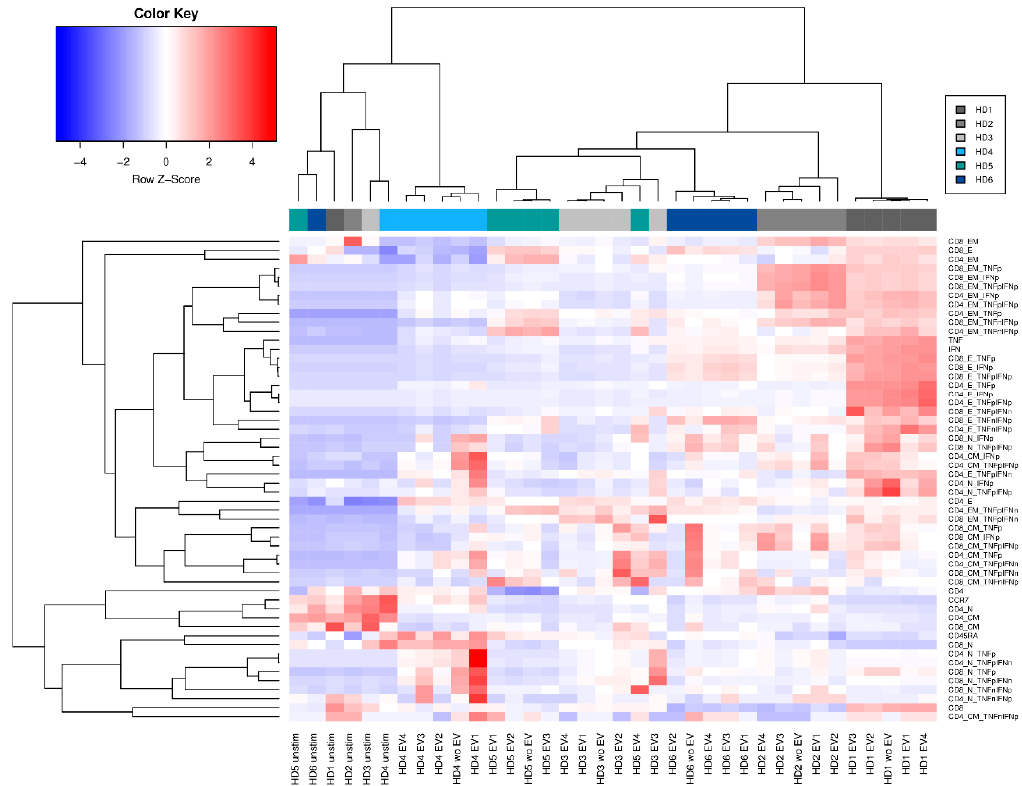
Figure 5. Hierarchical clustering regarding individual peripheral blood mononuclear cells (PBMC) responsiveness to MSC-EV. Clustering was performed with all factors included in the flow cytometric analysis. Compared was the effect of four different MSC-EV preparations (EV1–EV4) on PBMCs from six healthy donors six healthy donors (HD1–HD6).